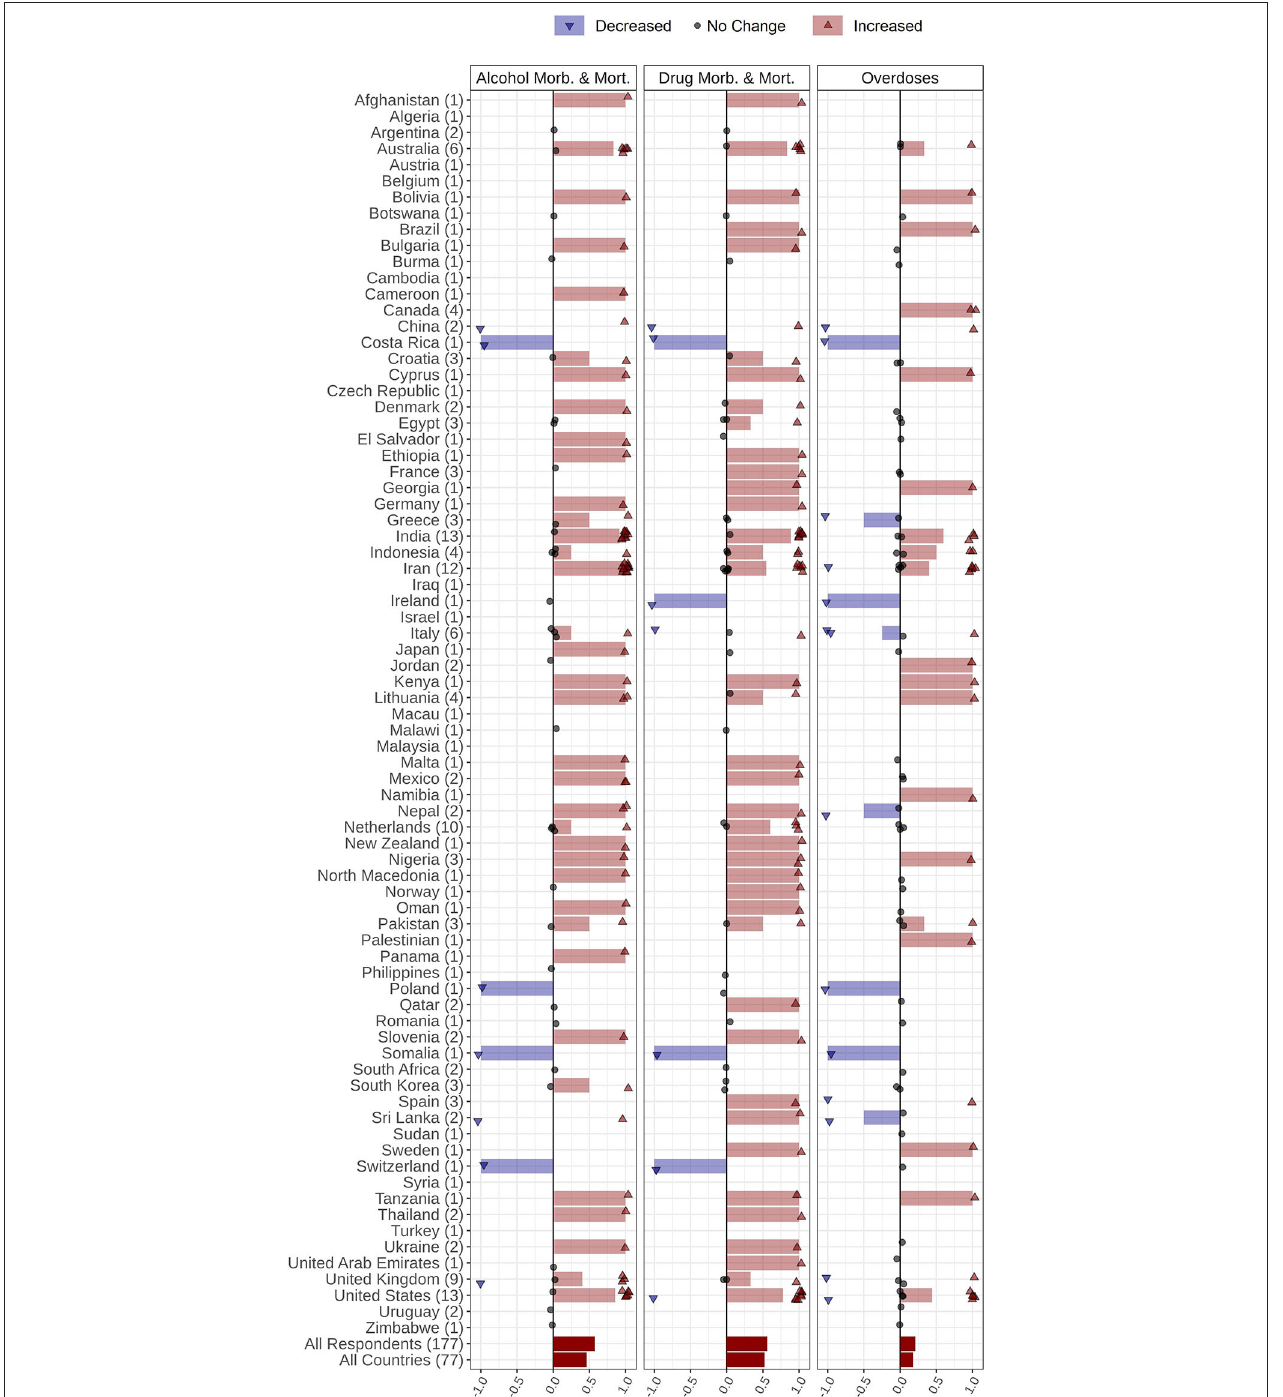
FIGURE 5 | Changes in mortality, morbidity, and overdose in people with SUD during the COVID-19 pandemic reported by 177 respondents from 77 countries around the world. Respondents were asked to report changes in morbidity or mortality rates in people with SUD and changes in fatal and non-fatal overdose episodes through the following options: Increased, Decreased, I do not know, I do not like to answer, and Not applicable. Countries’ names are sorted in alphabetical order, and the number of each country’s respondents is mentioned in front of the names. Each response is indicated as a single dot for no change or up and down triangles for increased and decreased answers, respectively, with a minor jitter for better visualization. The reported answers are represented as − 1 for decreased , 1 for increased , and 0 for no change; I do not know, I do not like to answer , and Not applicable answers are not shown in the figure. The mean of all responses, regardless of their originated countries and without considering those who did not know the answer, alongside the average answers of all countries, regardless of the number of respondents in each country, are addressed in the last two rows below the countries’ names (SUD, Substance Use Disorder).